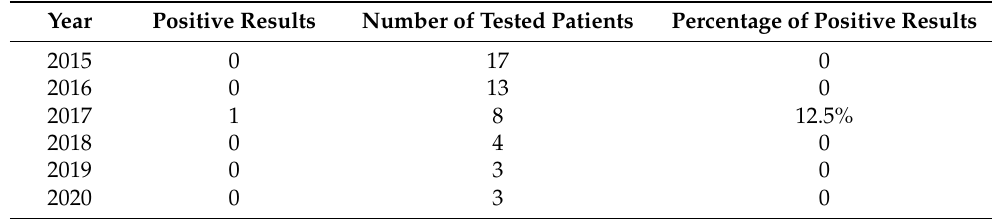
Table 9. Anti-Aspergillus antibodies (IgG) in PCICU patients.